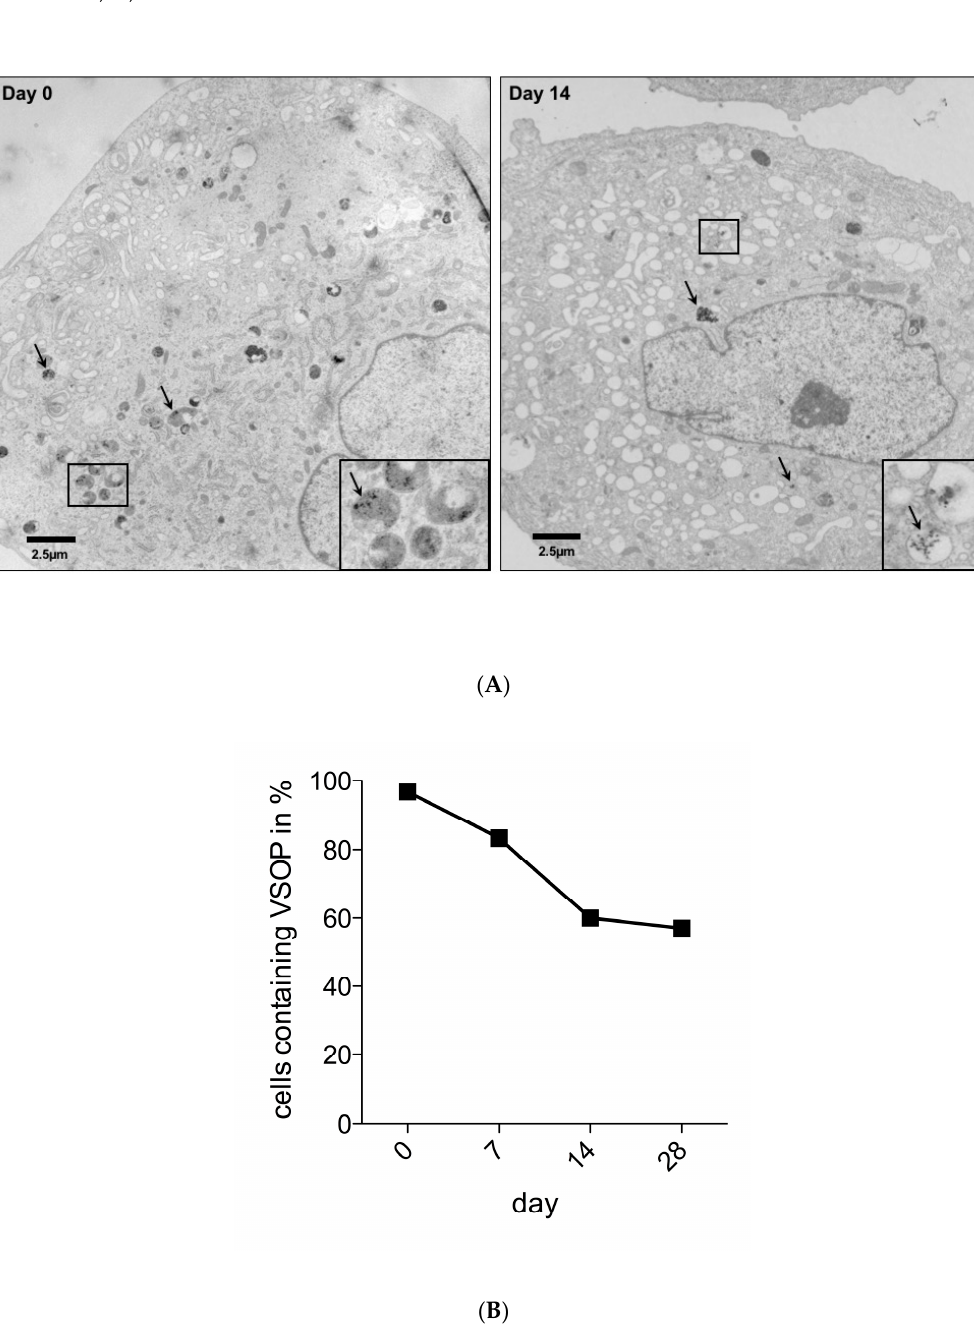
Figure 2. A: TEM image analysis: A: Intracellular distribution of intravesicular VSOPs in human ASCs immediately after (day 0) and two weeks (day 14) after labelling. The black arrows show examples of vesicles containing conglomerates of VSOPs (scale bar represents 2.5 µ m). The inserts with higher magnification of individual vesicles illustrate the aggregation and deposition of VSOPs in the cytoplasmatic vesicles. B: Distribution pattern retrieved by TEM image analysis: A total of 20 cells from three patients were counted for each time point in time and the value of unlabelled cells was compared to the labelled hASCs. Analysis of the TEM images over time revealed a decrease in the percentage of labelled hASCs.